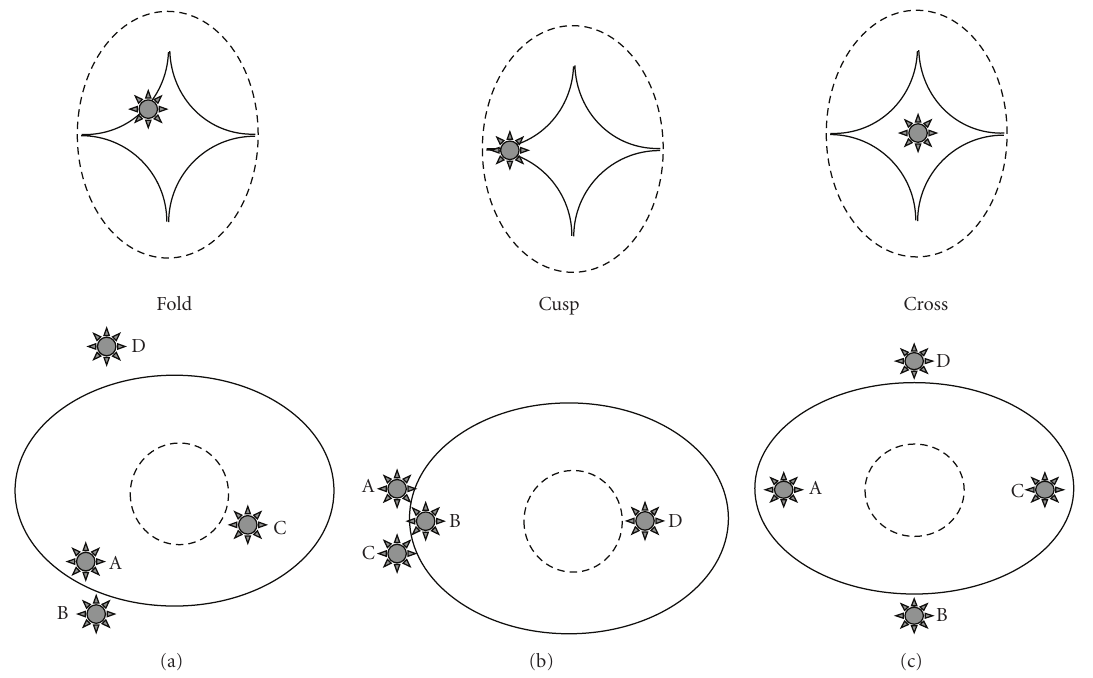
Figure 4: Di ff erent configurations of a four-image lens: (a) Fold, (b) Cusp, and (c) Cross. The upper row shows the caustics and position of the source (star) in the source plane. The solid line indicates the inner caustic and the dashed line the outer caustic. A source positioned inside the inner caustic produces five images; A source positioned between the inner and outer caustic produces three images, whereas a source positioned outside the outer caustic will not be multiply imaged. In the case of multiple images, one of the images is usually highly demagnified, so that only four- and two-image lens systems are observed, respectively. The lower row shows the corresponding critical lines and resulting observable images in the lens plane. The inner caustic maps on the outer critical line and vice versa. A close pair (A, B) and a close triplet (A, B, C) are produced in the fold (a) and cusp (b) configurations,